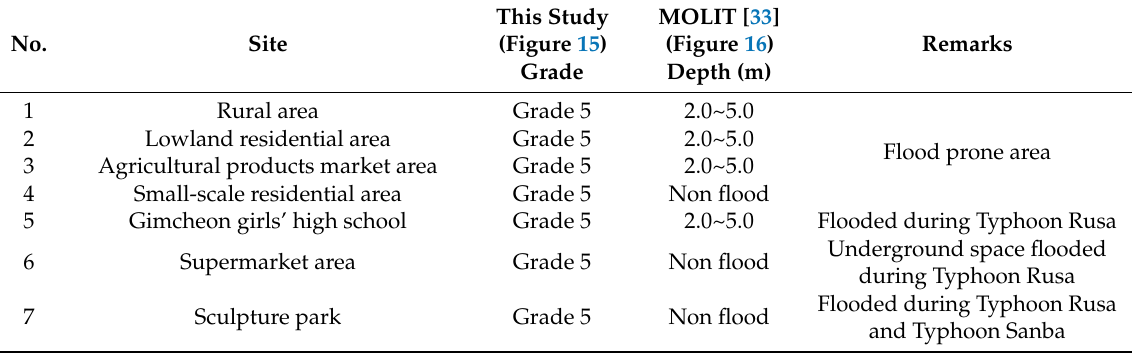
Figure 15. Flood hazard map of this study. Table 3. Comparison of flood hazard map between this study and MOLIT in the real flood